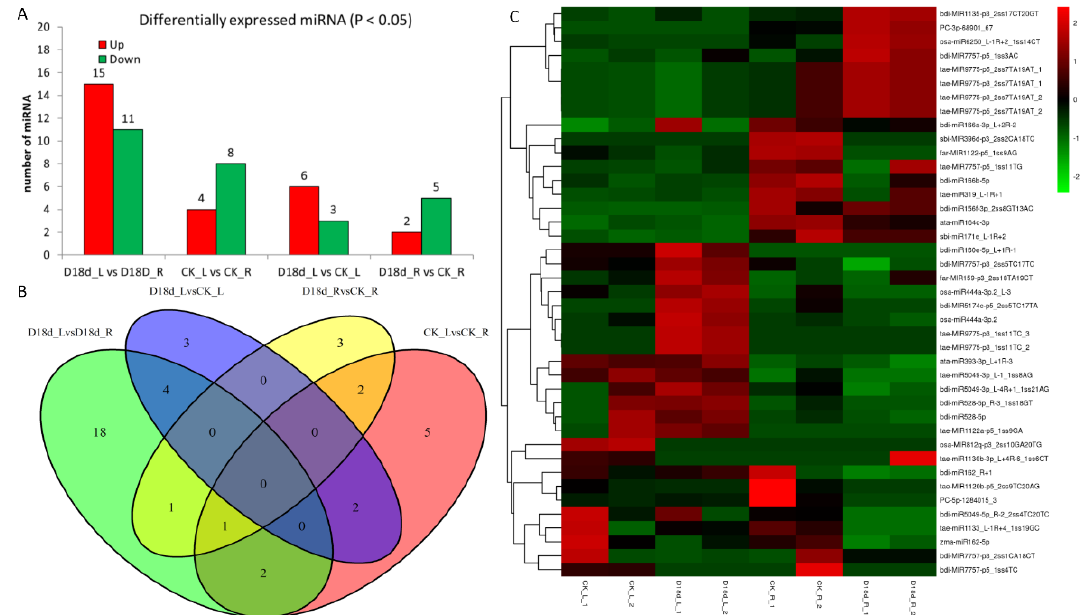
Figure 5. Analysis of differentially expressed miRNAs (DEmiRs) in orchardgrass exposed to drought. ( A ) Barplot of DEmiRs from different groups with significance threshold of 0.05; ( B ) Venn diagram of different comparison groups ( p -value < 0.05); green color represent to comparison of drought treated leaf to root; purple color represent to comparison of drought treat leaf to controlled leaf; yellow color represent to comparison of drought treat root to controlled root; pink color represent to comparison of controlled leaf to root; ( C ) expression heatmap of the 41 DEmiRs (the samples names are shown at the bottom). The original expression values were normalized by Z-score normalization. With color changes from green to red, the absolute signal intensity ranges from − 2.0 to +2.0.